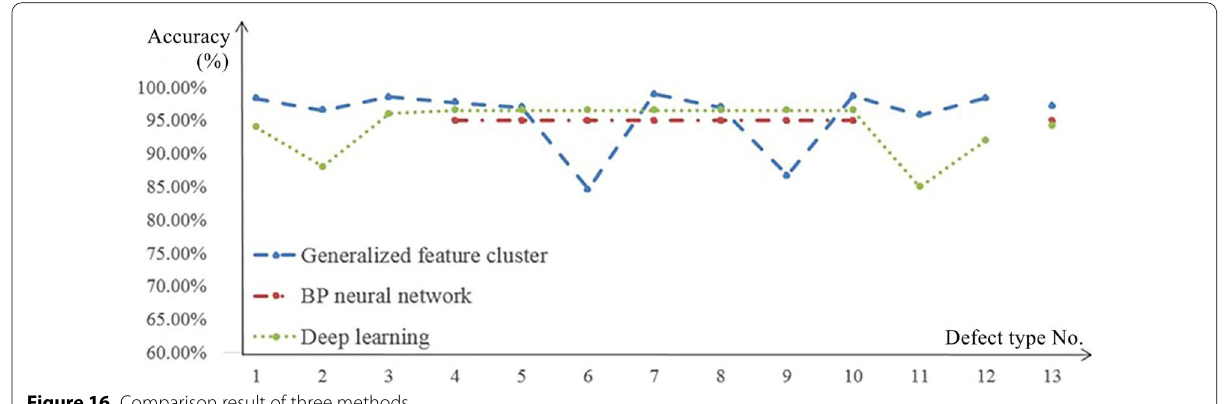
Figure 16 Comparison result of three